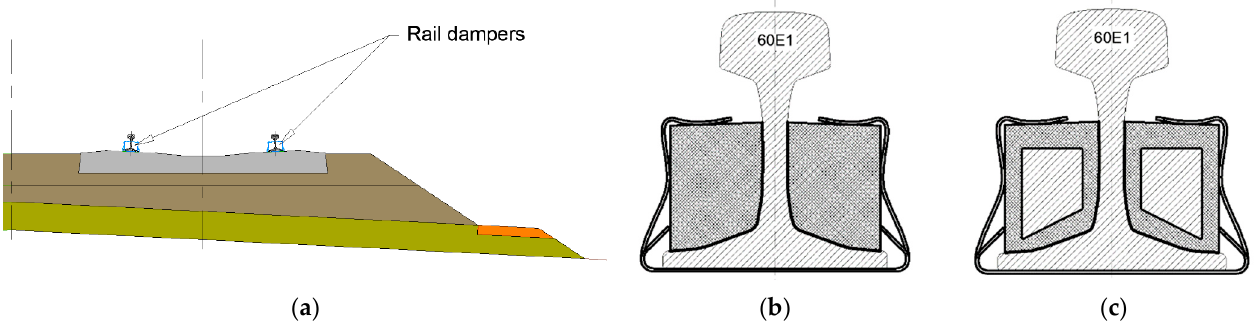
Figure 1. Prototype rail dampers: ( a ) Schematic location within the ballasted track structure; ( b ) Cross-section of a static damper; ( c ) Cross-section of a dynamic damper with a steel insert and an elastic cover based on rubber granulate SBR.